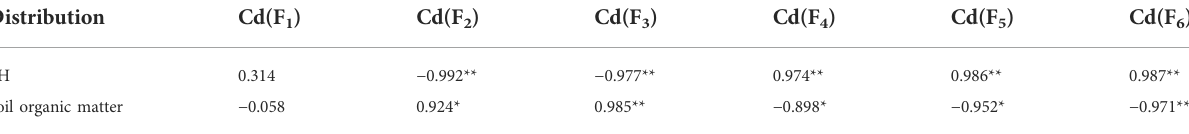
TABLE 4 Pearson ’ s correlation among soil pH, soil organic matter, and distribution (F 1 ~F 6 ) of Cd.